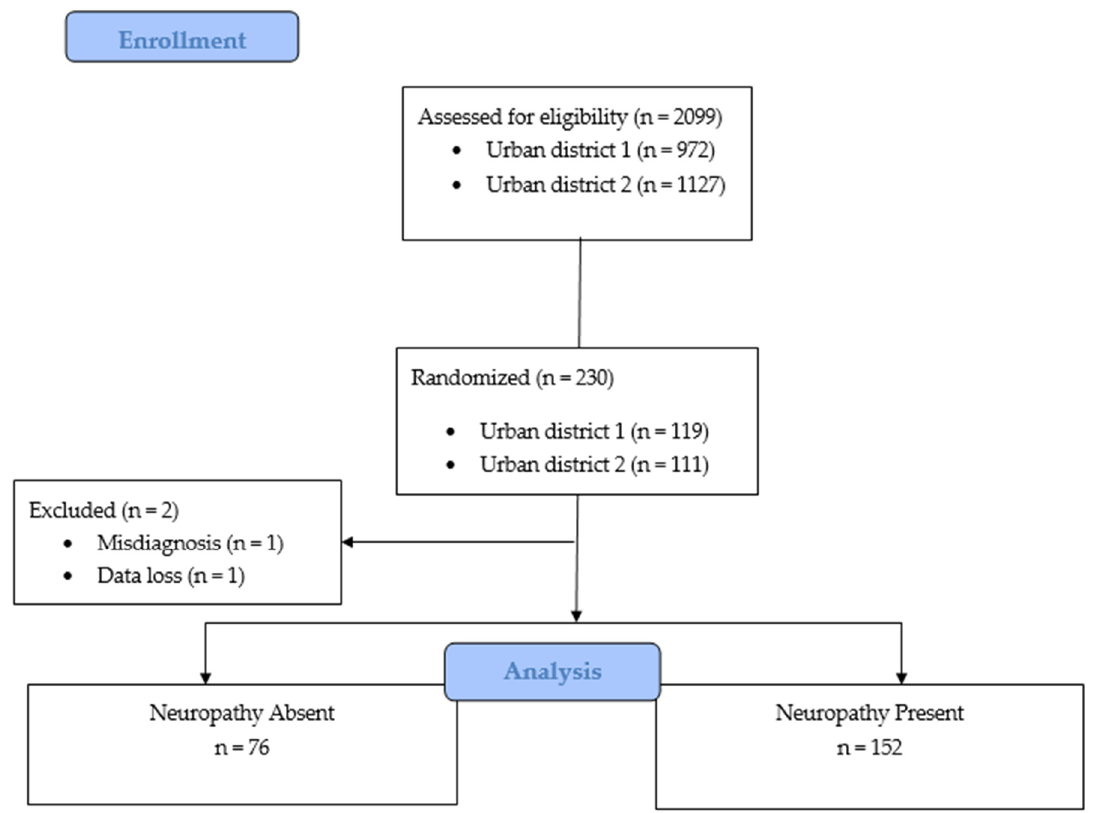
Figure 1. Flow diagram of the selection and distribution of individuals in the groups.